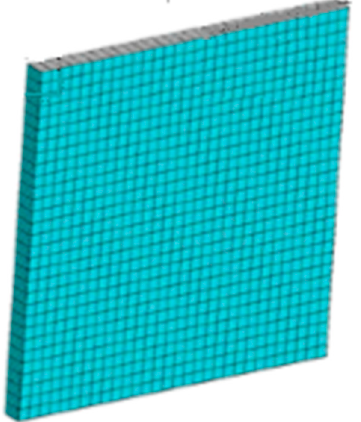
Figure 2. Particular of the door mesh.